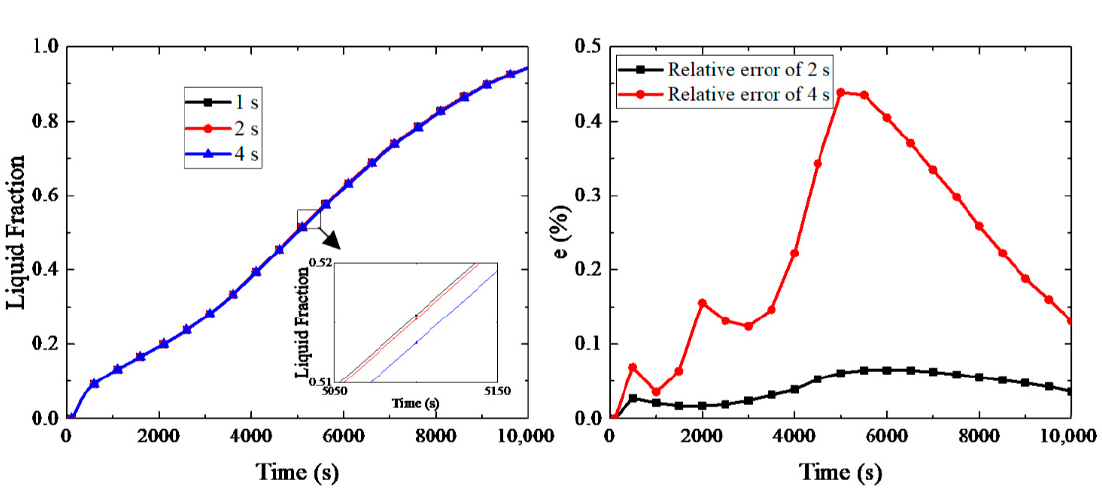
Figure 6. Results of grid-independent analysis.